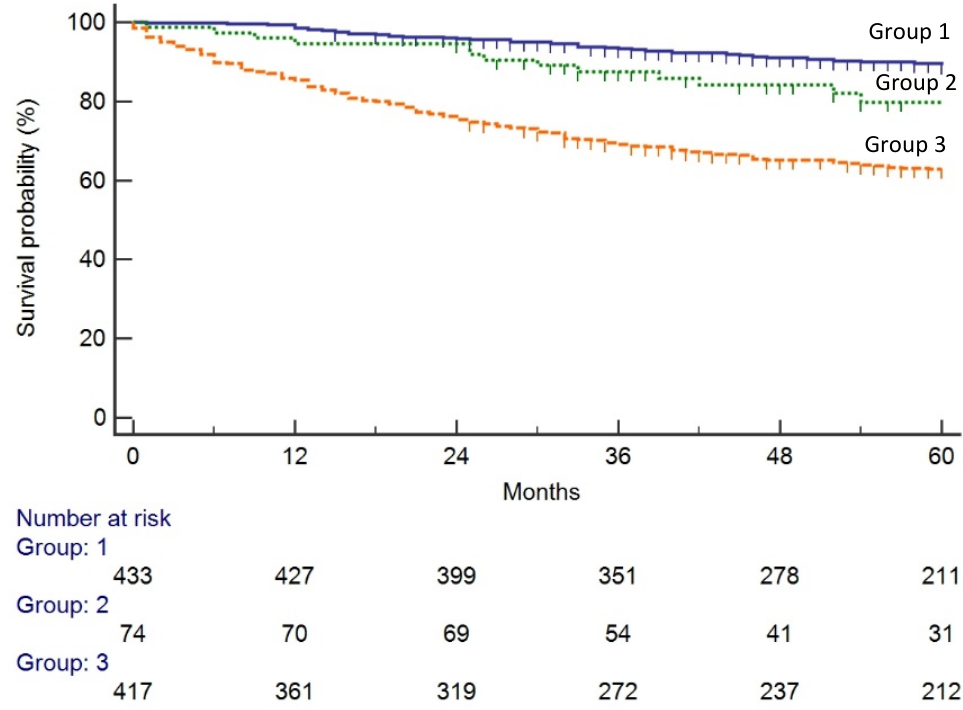
Figure 2. Kaplan-Meier overall survival curves by group. (Group 1: screen-detected CRC; Group 2: symptomatic patients with positive faecal immunochemical test results in the previous 12 months; Group 3: symptomatic patients who did not undergo faecal immunochemical testing or had a negative FIT result). Table 3. Association of variables with overall survival (univariate and multivariate analysis).